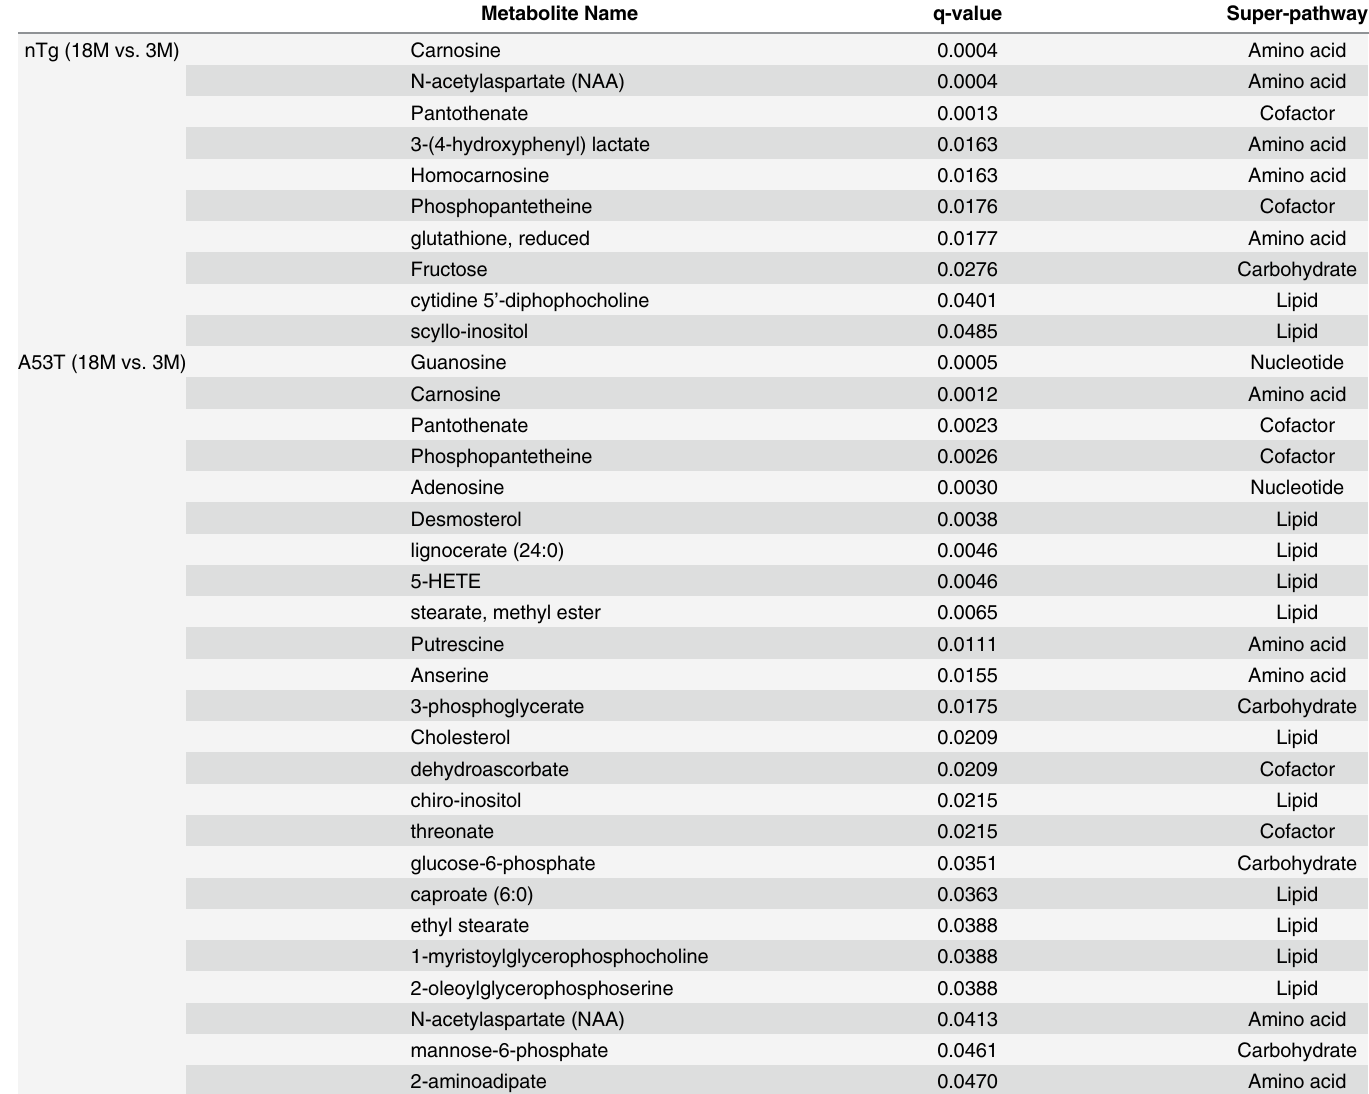
Table 1. A list of metabolites substantially affected by aging based on the one-way ANOVA